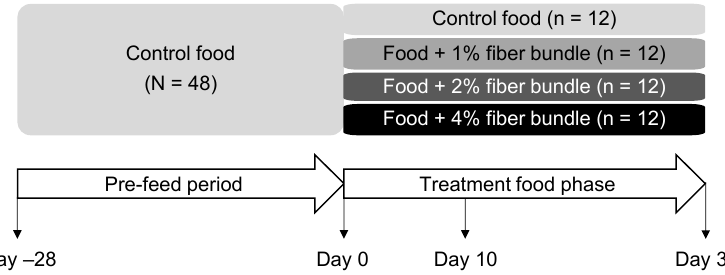
Figure 1. Study design and timeline in which dogs consumed foods containing 0%, 1%, 2%, or 4% of the fiber bundle for 31 days. Blood and fecal samples were collected at days 0, 10, and 31 of the treatment food phase.